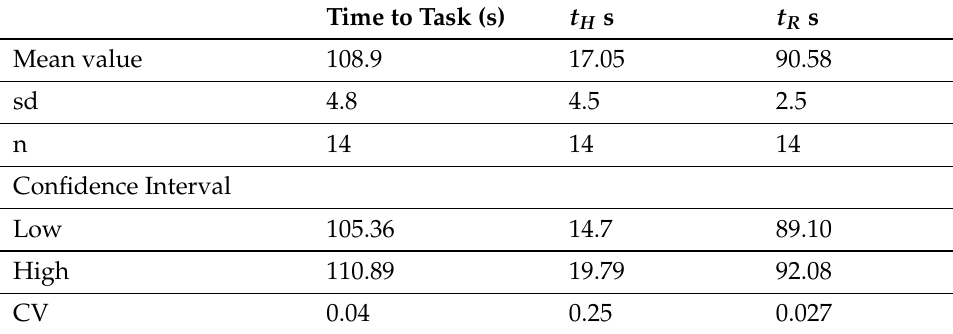
Figure 11. Time to Task for Task 2. Table 10. Statistics times in Task 2.